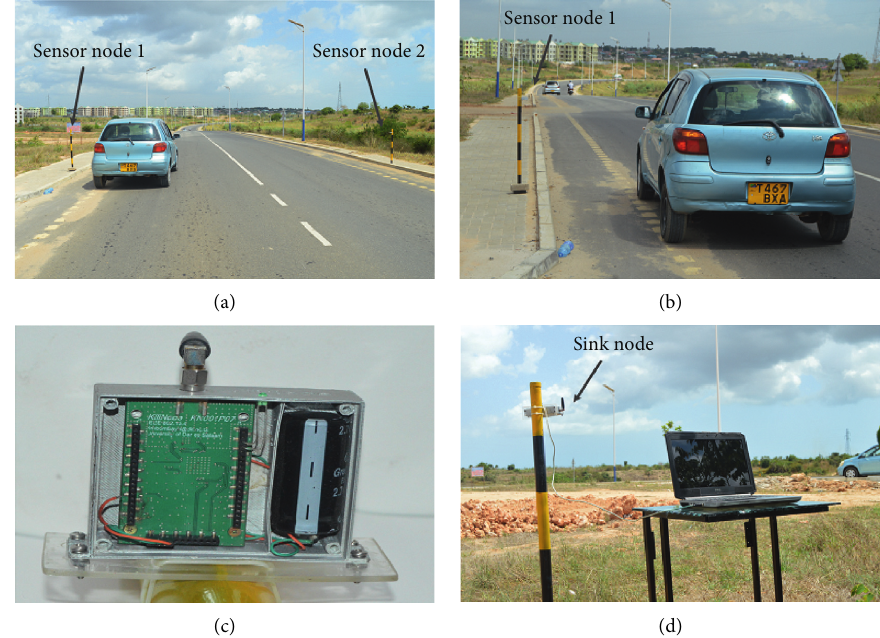
Figure 2: On-site real-time experiment setups. The two sensors communicate with the sink node wirelessly which is situated at 100m away.